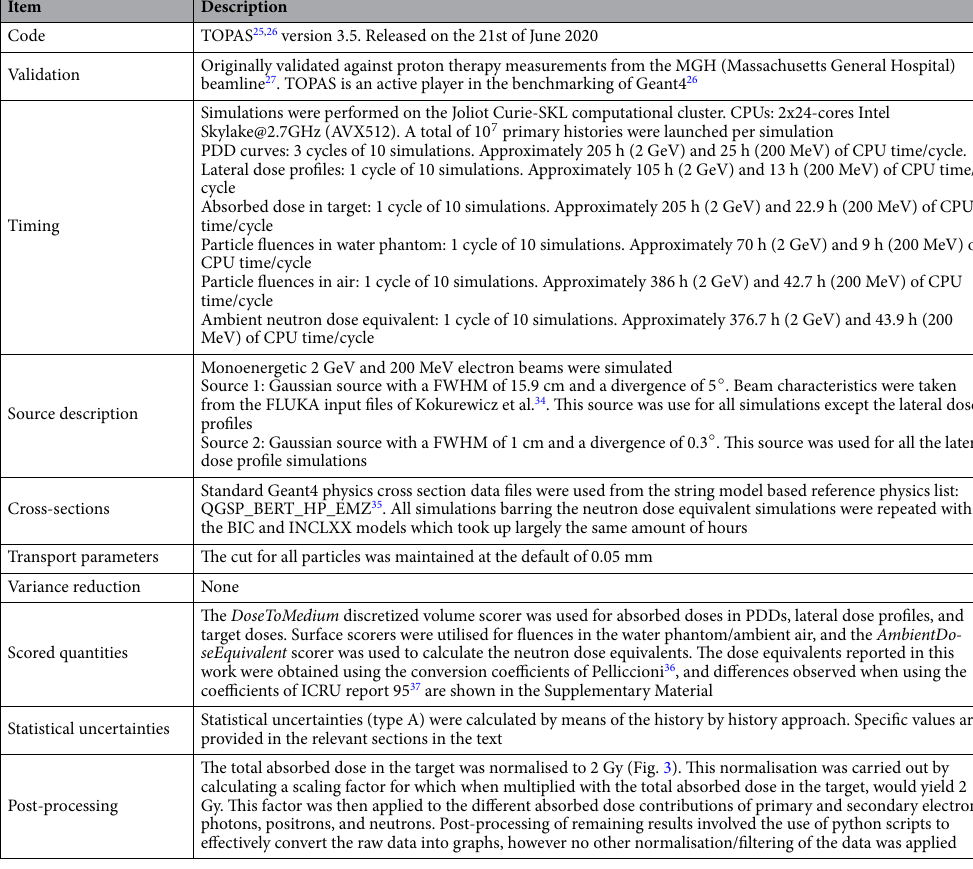
Table 1. Summary of the main characteristics of the MC